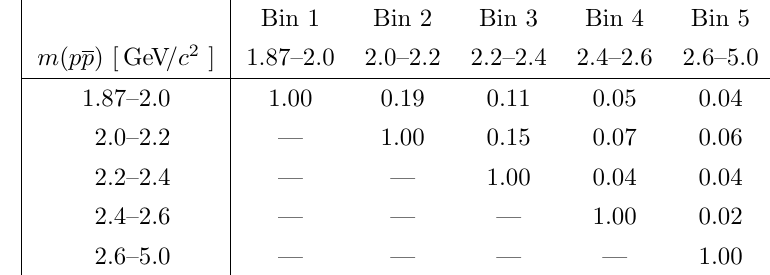
Table 4 . Correlations in the uncertainties between bins of m ( pp ).